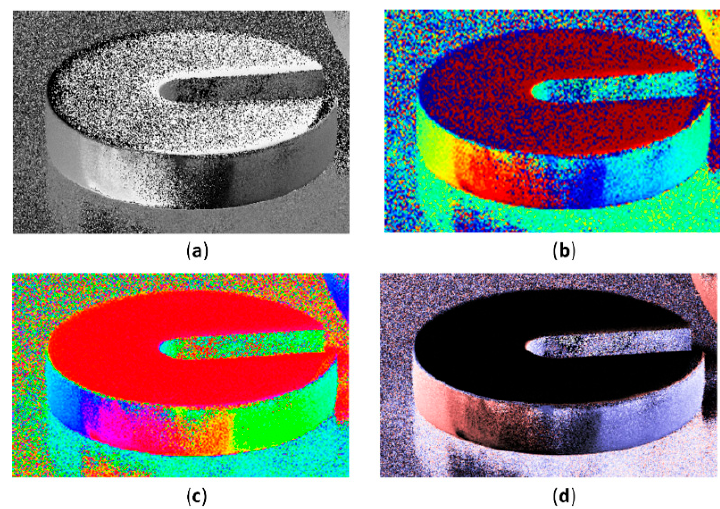
Figure 6. Experiment results for AoP visualization method. ( a ) Light intensity image; ( b ) AoP image by previous method 1; ( c ) AoP image by previous method 2; ( d ) AoP image by previous method 3; ( e ) AoP image by our method. The characterization noise is suppressed in ( d ) and ( e ). The AoP images are intuitively in agreement with their shape in ( c ) and ( e ), especially in the complex scene 4.